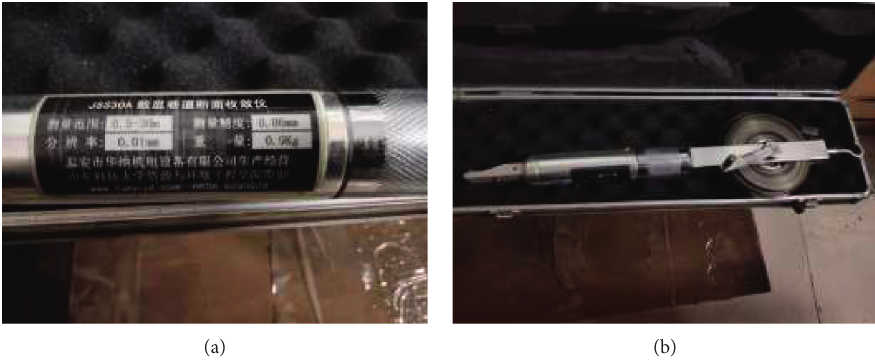
Figure 15: JSS30A digital display roadway section convergence